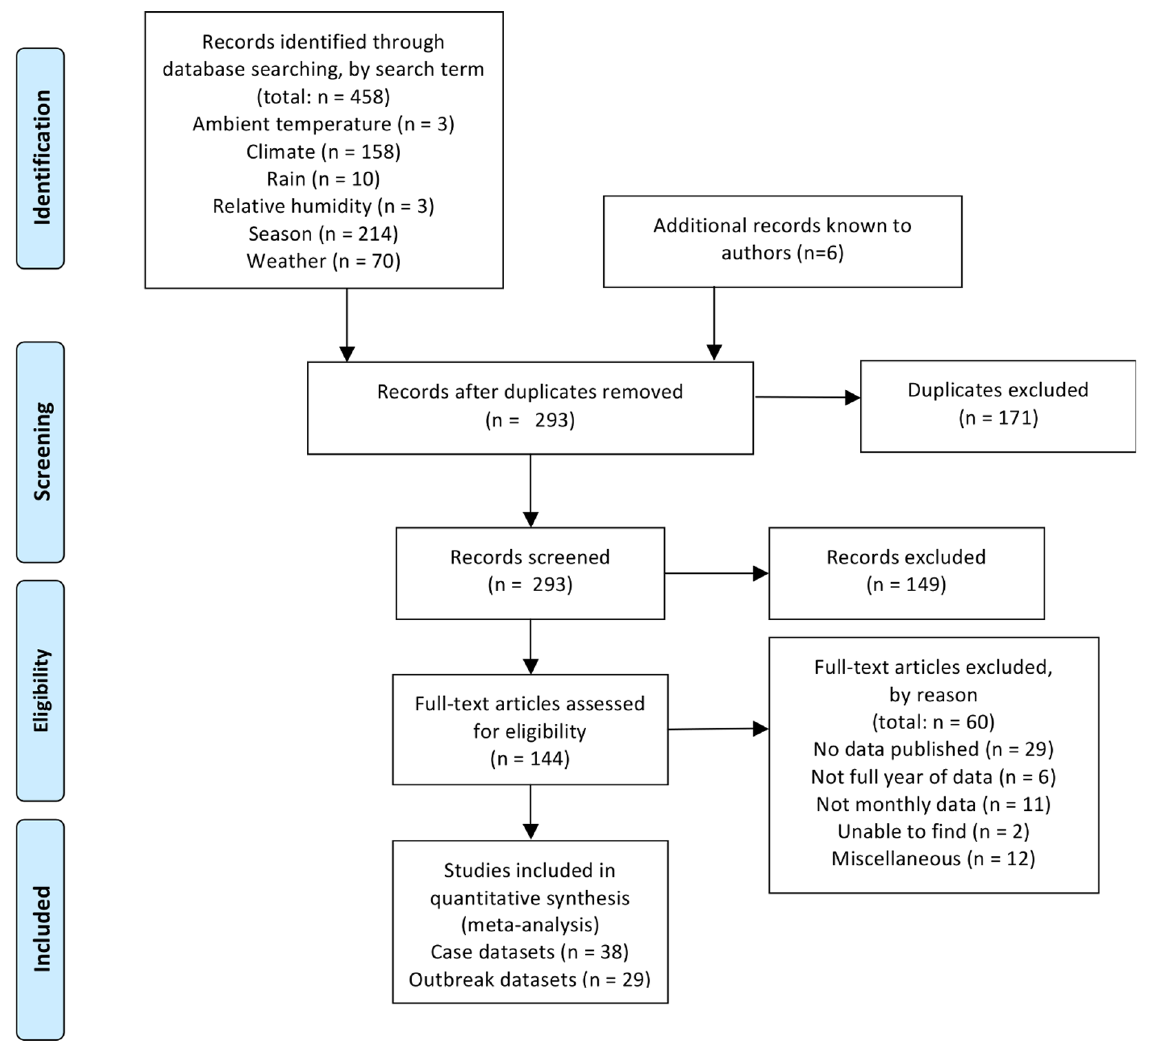
Figure 1. Flow chart of search strategy. Note that final numbers refer to total number of data series included in analyses, whereas other numbers refer to numbers of articles reviewed.